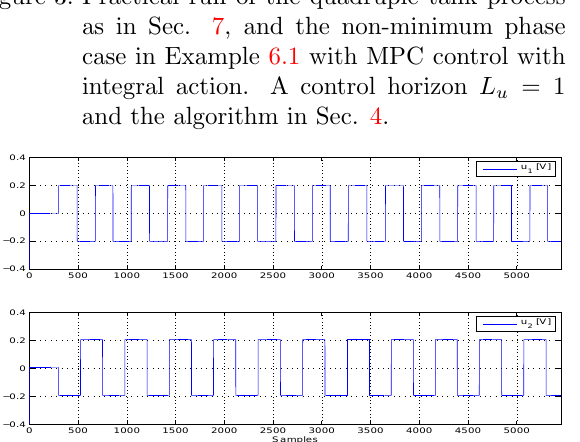
Figure 4: Open loop system identification input exper- iment, i.e. the volt input to the pumps.